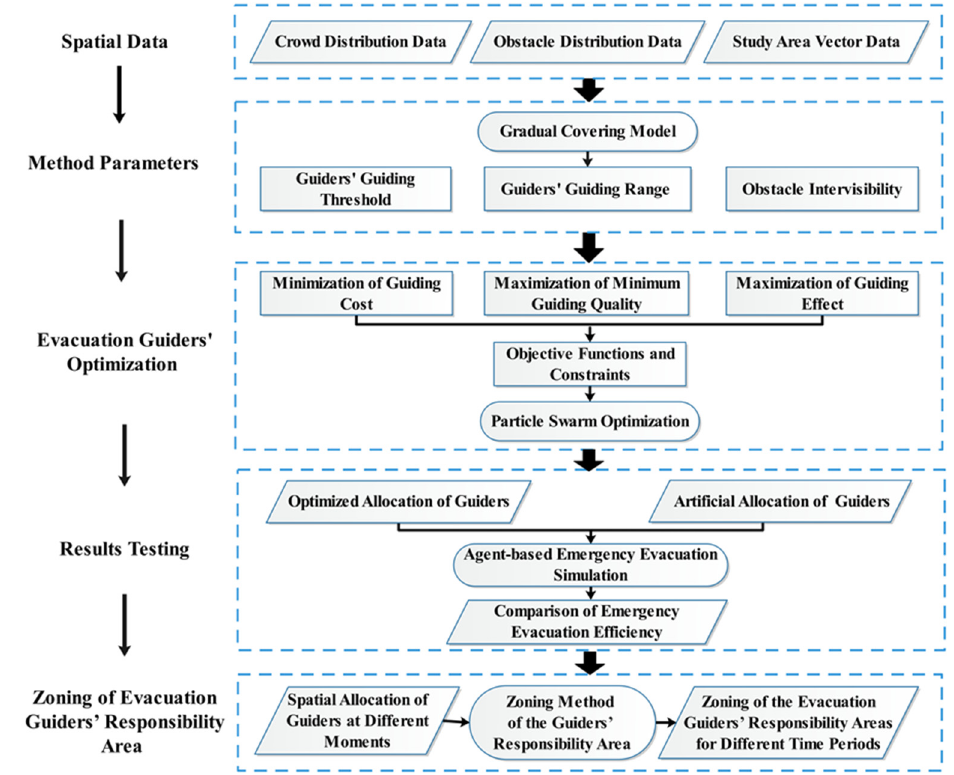
Figure 3. Schematic of the solution procedure for the allocation of evacuation guiders in urban open public spaces.